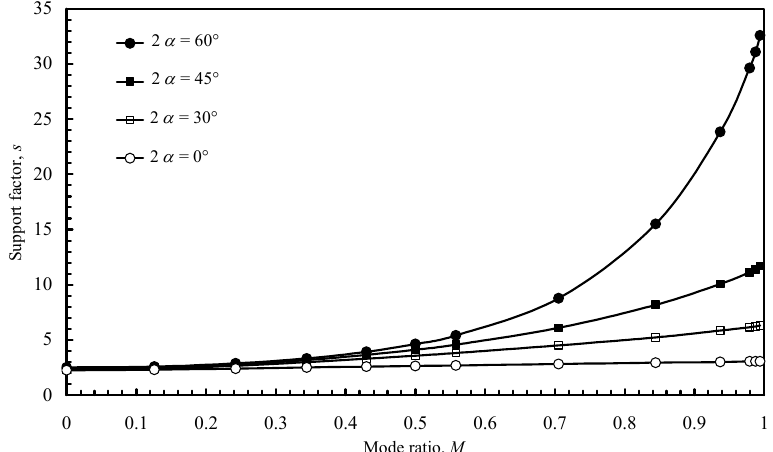
Figure 2: Support factor s as a function of the mode ratio M for different values of the notch opening angle 2 